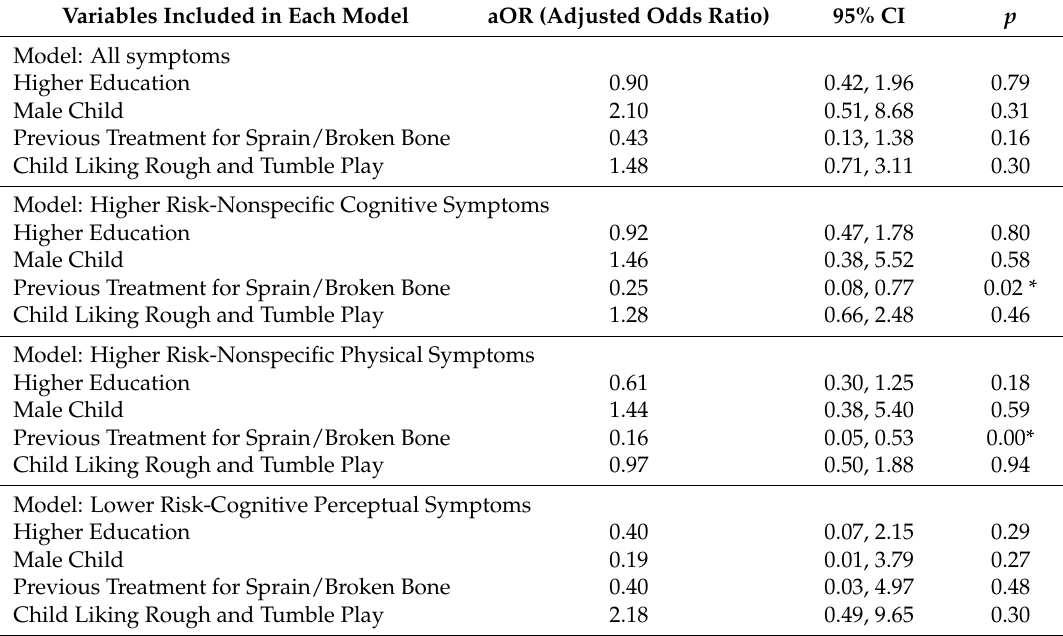
Table 4. Adjusted odds ratios for logistic regression models for caregivers’ intent to seek treatment for concussion